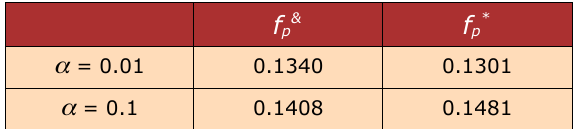
Table 1. The impact of network externalities on optimal qualities under case II and ca se III